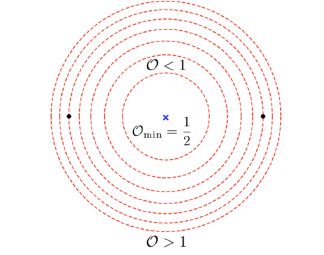
Figure 1: Illustration of the geometry selected for by the observable of the final-state hard partons are denoted by the black dots, and the passes through them. Figure reproduced from [ 1 ] , used under CC-BY